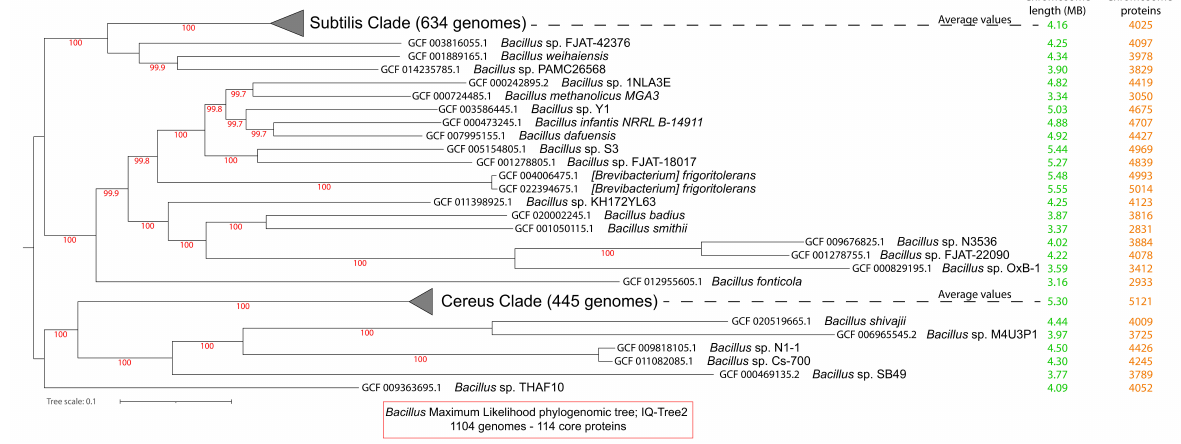
Figure 1. The phylogenomic maximum likelihood tree (IQ-Tree2) of the 1104 Bacillus proteomes. The tree was based on 114 core proteins and 20,041 variable sites, using the LG + I + F + G4 model and aLRT. For ease of visualization, the entire Subtilis and Cereus Clades are collapsed. Next to each leaf of the tree, the chromosome size, and the number of all chromosomally encoded proteins are